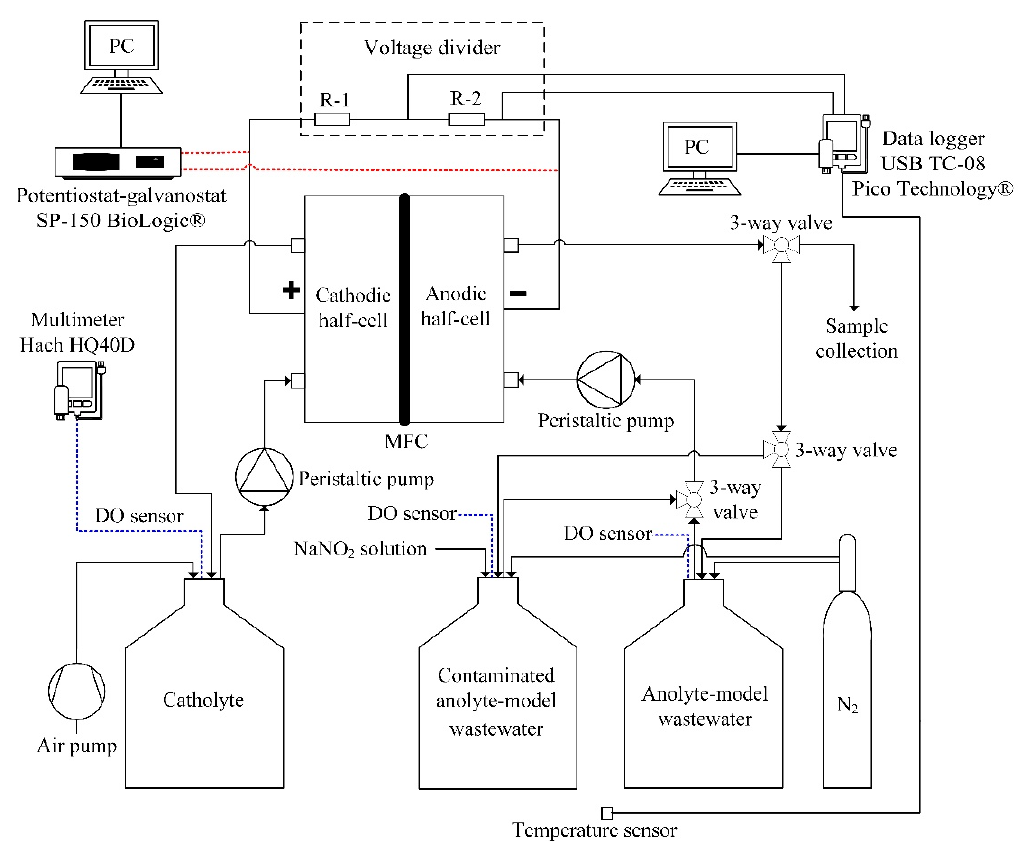
Figure 1. The setup of equipment used for investigation of a microbial fuel cell (MFC) as a nitrite ion biosensor. DO—dissolved oxygen; PC—personal computer; R—resistor.